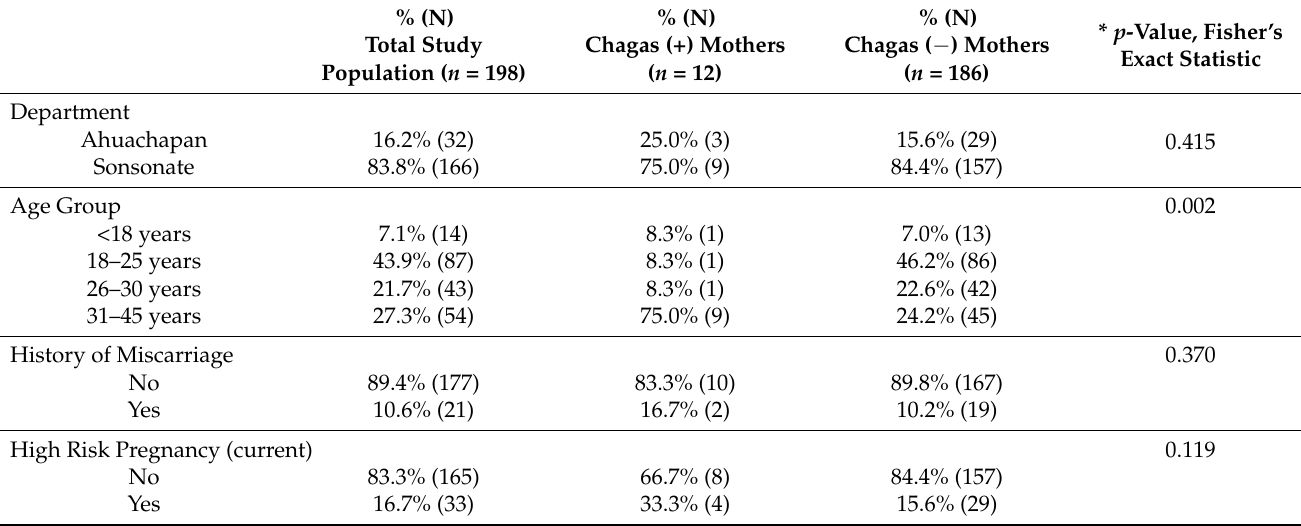
Figure 1. Recruited perinatal Salvadoran women represented all 16 of the Sonsonate department ( right ) municipalities, while 5 municipalities from the equally underserved neighboring Ahuachapan department were also represented ( left ). Table 1. Perinatal Salvadoran women primarily lived in low socioeconomic conditions and Chagas disease positivity was associated with several demographic factors.